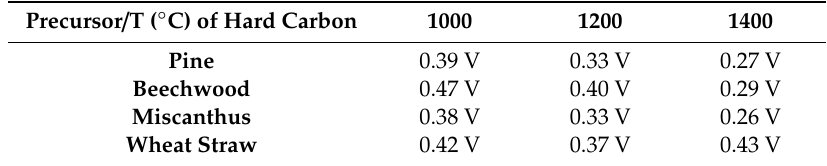
Table 3. Average voltage of the first cycle oxidation step (reversible extraction of sodium ions) of hard carbons.